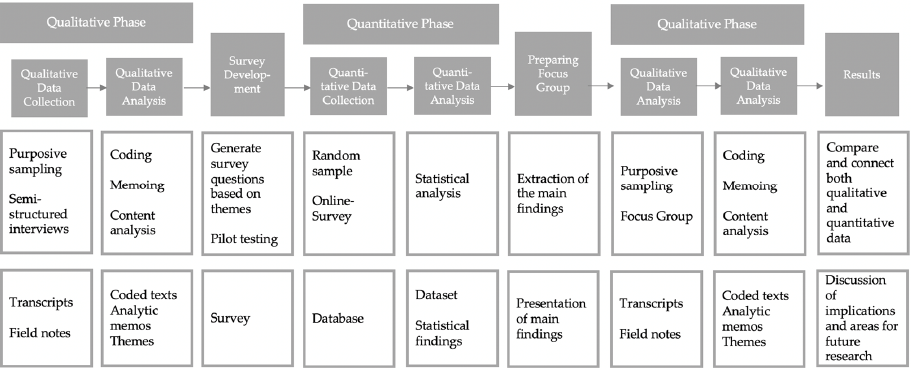
Figure 1. Mixed-methods study design.